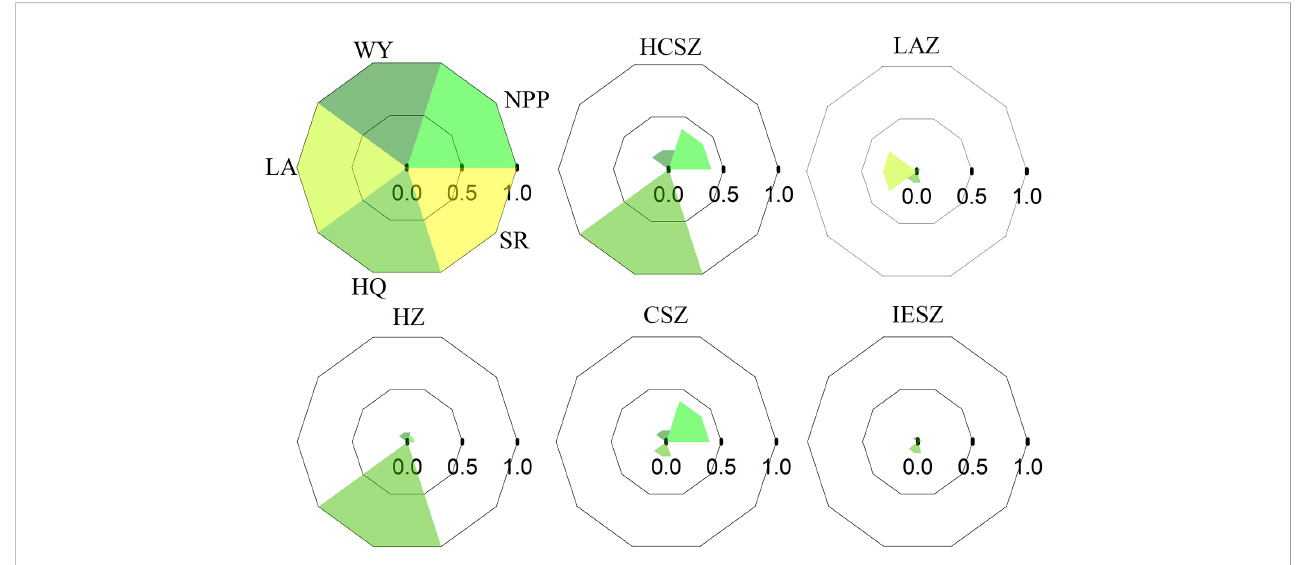
FIGURE 5 Five ES bundles in the QTP from 2000 to 2019. WY, water yield; SR, soil retention; HQ, habitat quality; LA, landscape